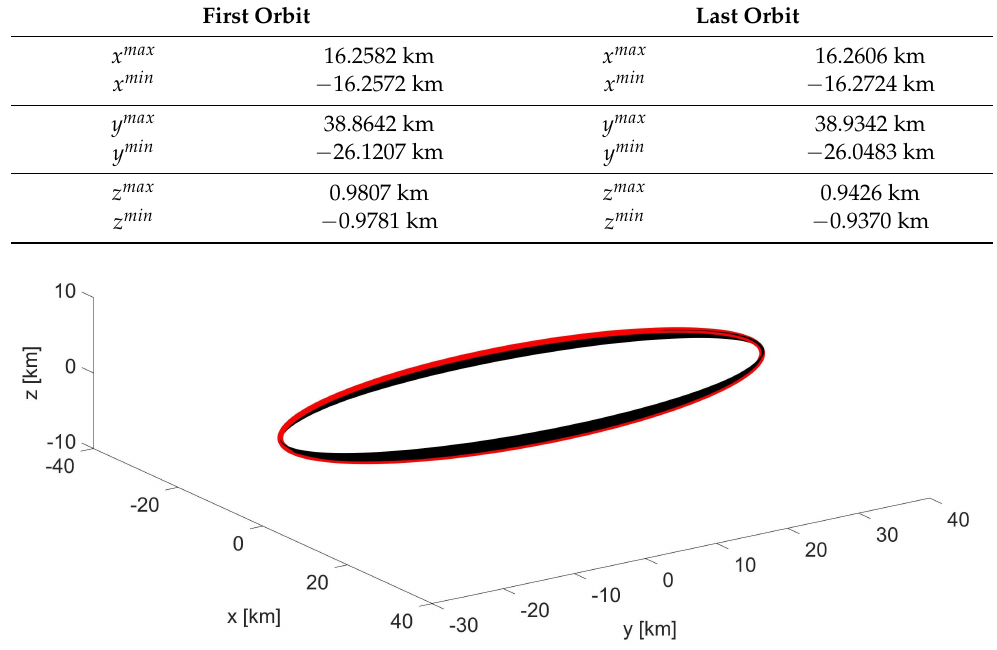
Figure 1. SSO formation: J n -invariant bounded trajectory (black) in F r ; the first orbit is plotted in red.